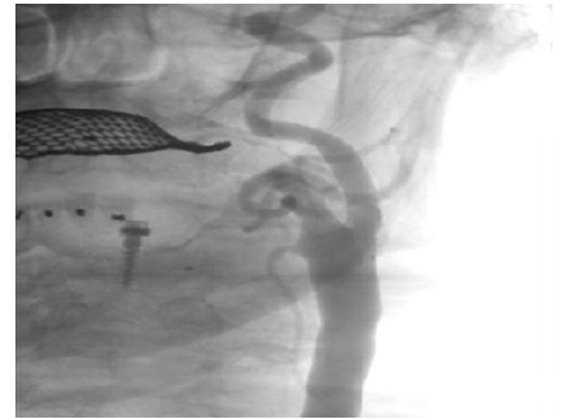
Figure 2. Catheterizing of the left common-and internal carotid artery and stent implantation.